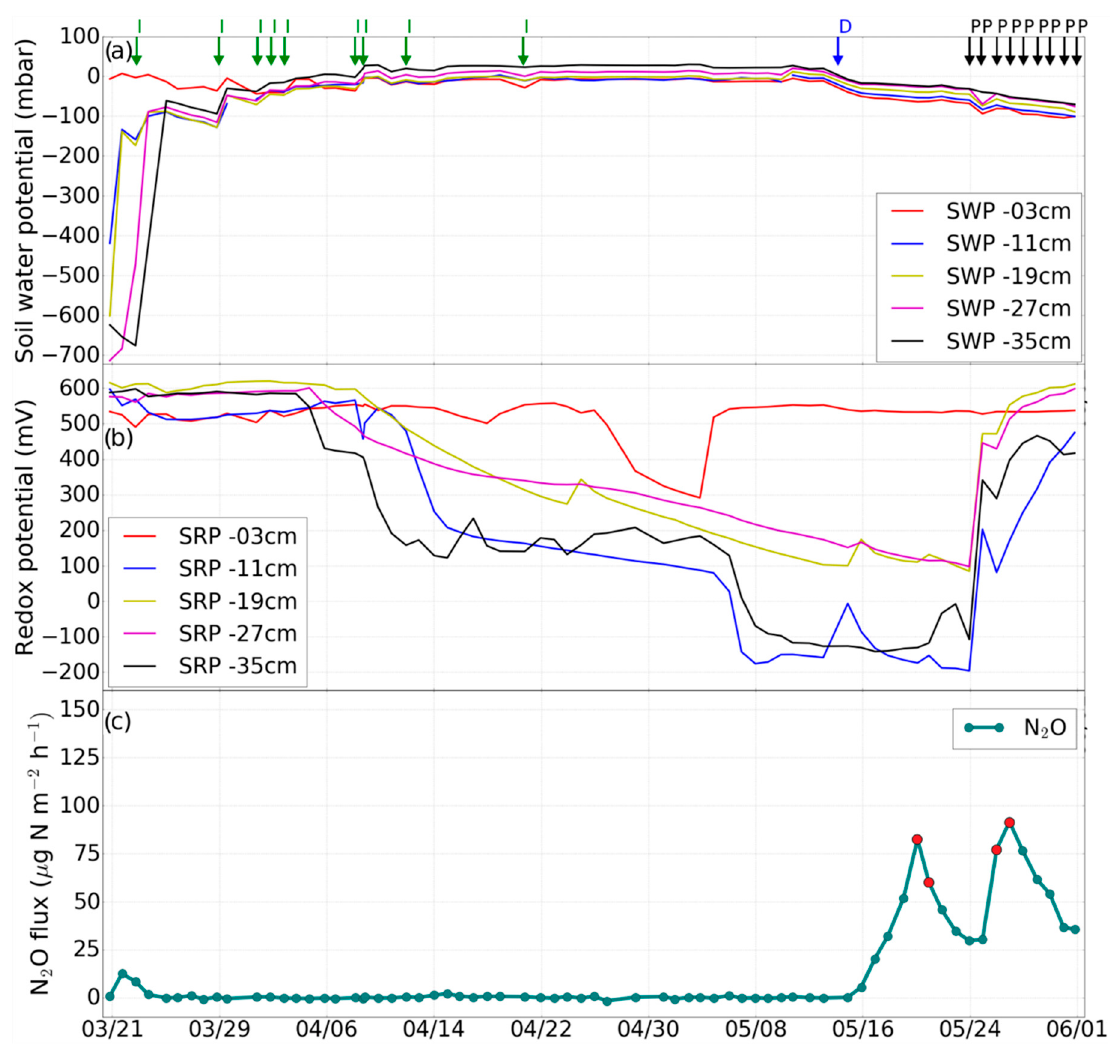
Figure 2. Experiment 1 (before fertilization). Changes in ( a ) soil water potential (SWP), ( b ) soil redox potential (SRP), and ( c ) N 2 O emission rate induced by irrigation (I), drainage (D), irrigation with fertilizer (F), desaturation of the soil with pump (P). The red dots in panel c indicate the N 2 O isotope sampling days.